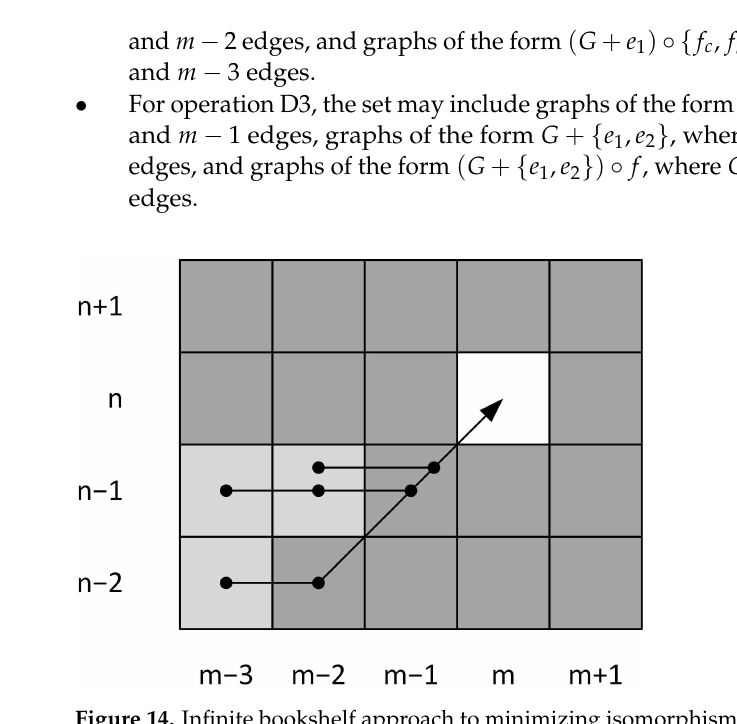
Figure 14. Infinite bookshelf approach to minimizing isomorphism